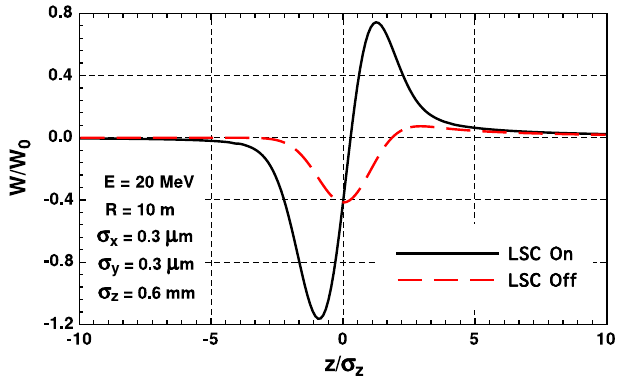
FIG. 20. (Color) The steady-state kick due to CSR alone and the combined CSR and SC kick for a 20 MeV beam.